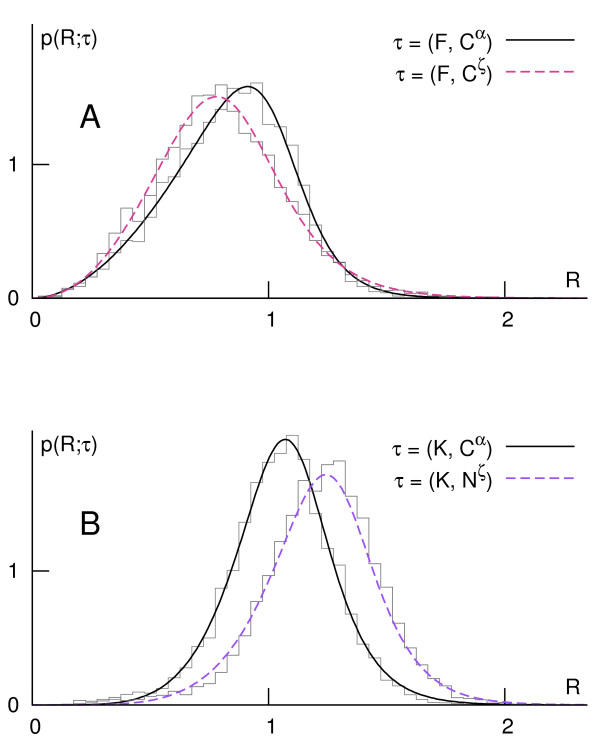
Probability densities of Cα and of the most distal side chain atom in Phe and Lys. The two amino acids exhibit the most prominent (the largest separation of the means) and opposite (centripetal, A, vs. centrifugal, B) orientational preferences.